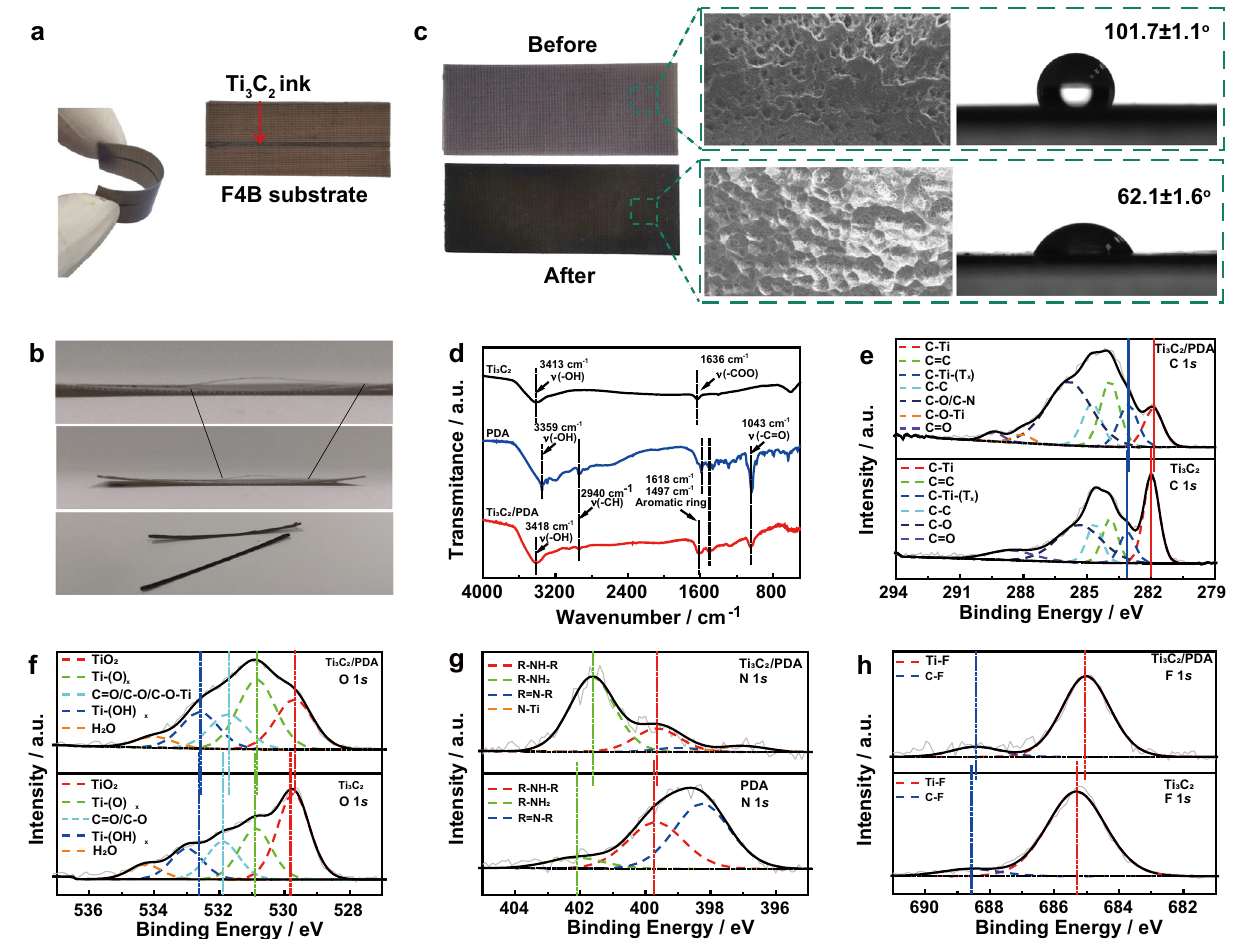
Fig. 2 | Characterization of Ti 3 C 2 microstrip transmission lines (TLs). a Digital images of fl at and bent Ti 3 C 2 microstrip TLs with PDA coating. b Digital images of Ti 3 C 2 microstrip TLs without PDA coating and the exfoliated Ti 3 C 2 layer. c Digital